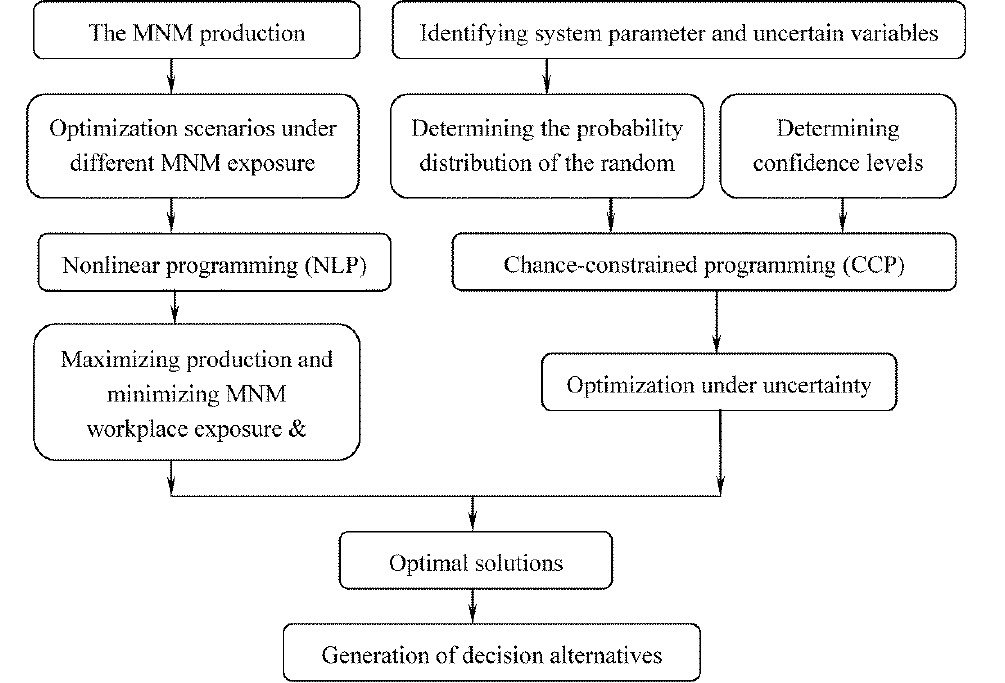
Figure 2. Framework of the CCNLP optimization method.